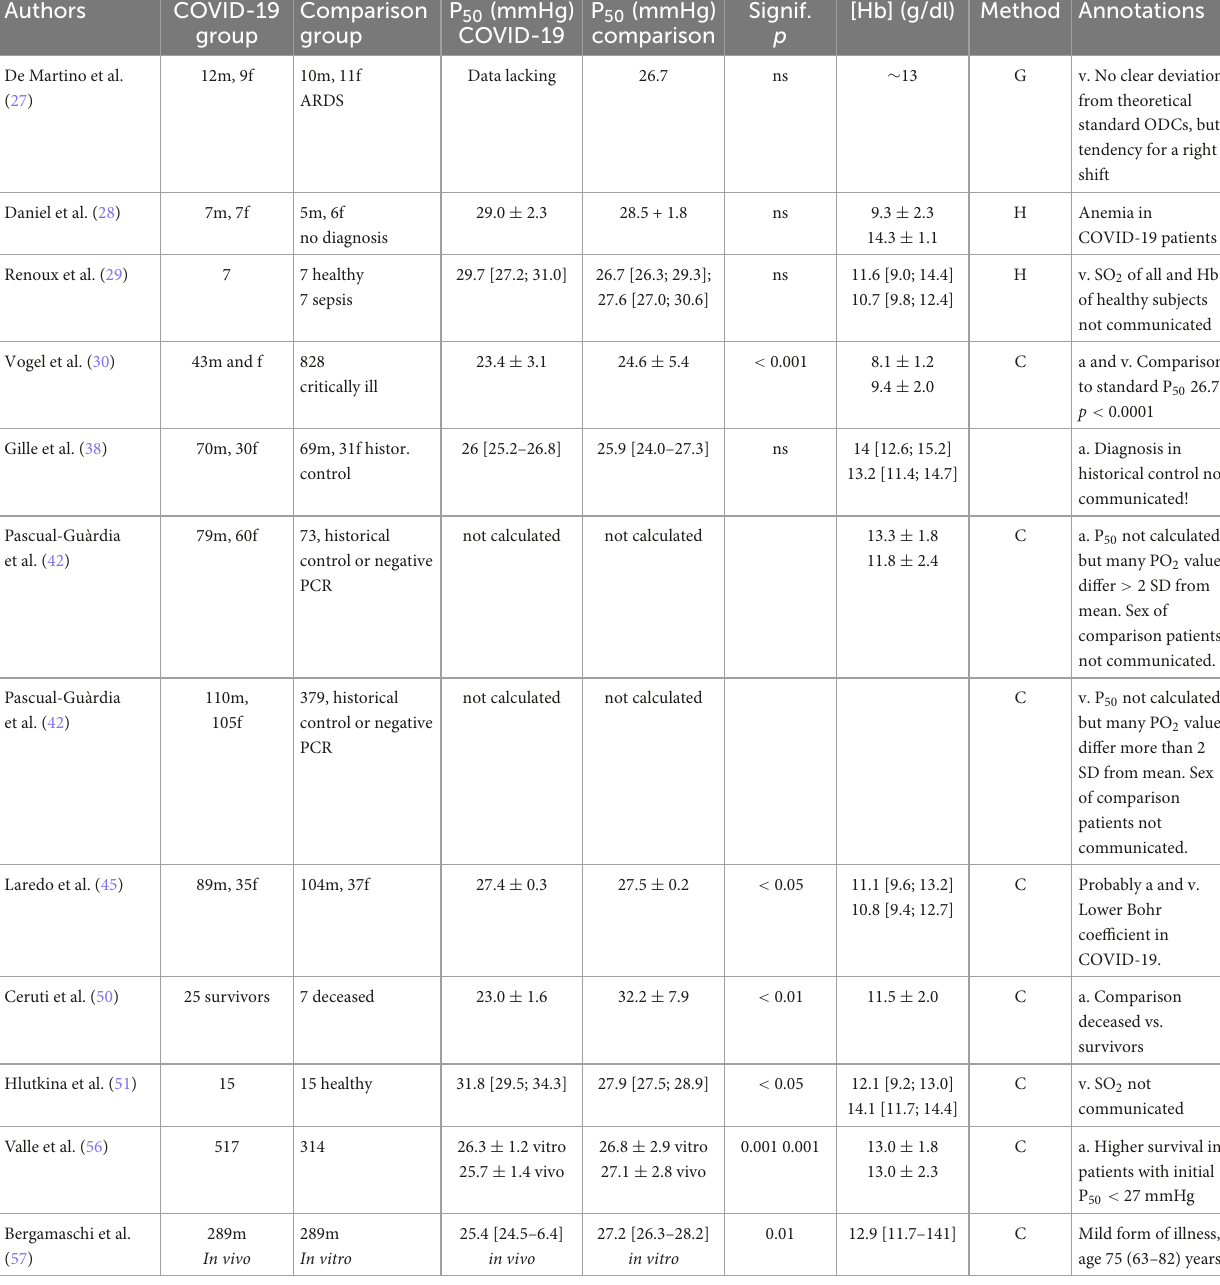
TABLE 2 Oxygen affinity in COVID-19